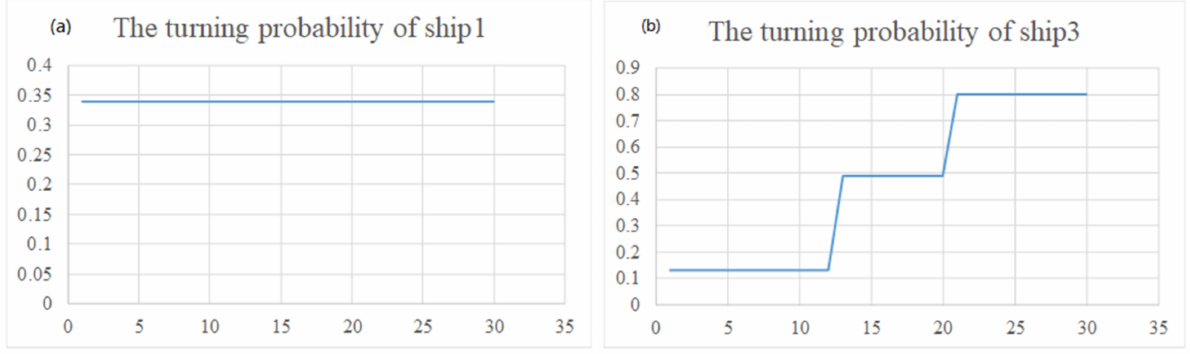
Figure 13. Simulation intention prediction results of direct ship. ( a ) The turning probability of ship1. ( b ) The turning probability of